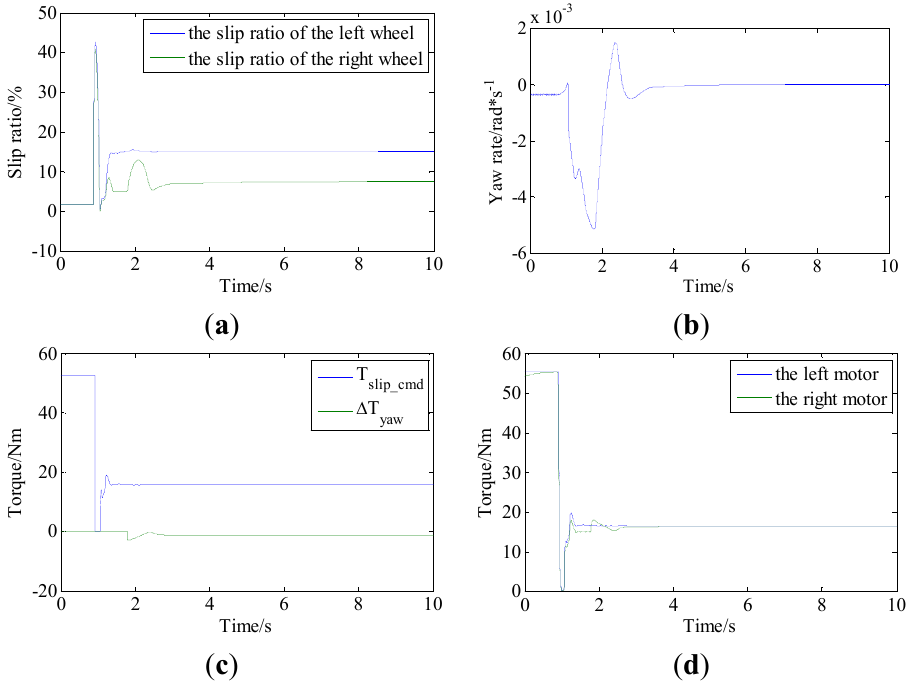
Figure 10. Simulation results of acceleration slip regulation on a varying friction coefficient road: ( a ) slip ratios of driving wheels; ( b ) yaw rate of vehicle; ( c ) torque commands of slip ratio control and yaw rate control; and ( d ) motor torque outputs.